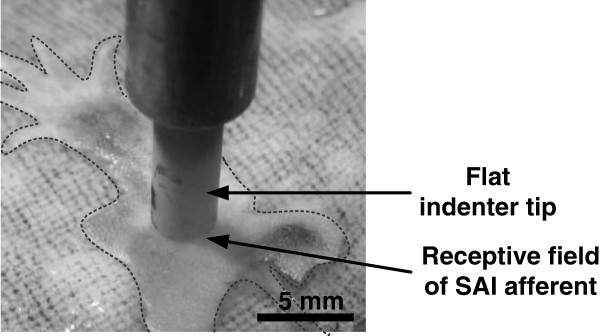
Set-up of SAI recordings. in mouse hairy skin (outlined) and indenter. Indenter tip is positioned over receptive field of mouse hairy skin (outlined).